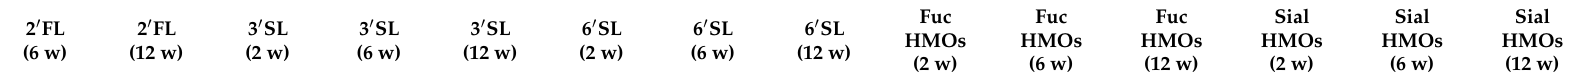
Table 4. Correlations between concentrations of individual HMOs and grouped